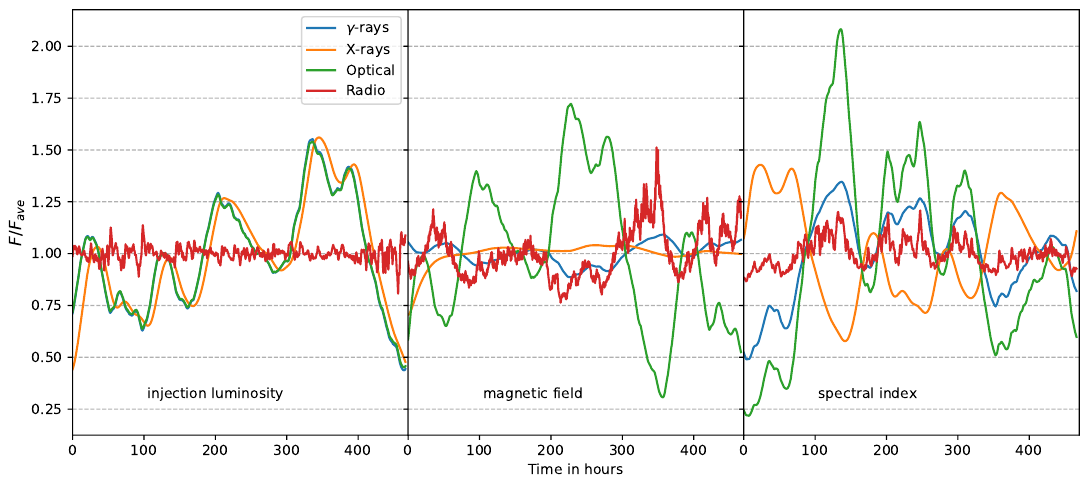
Figure 3. Light curves recovered for variations of injection luminosity ( left ), magnetic field ( middle ) and spectral index ( right ) generated from the time-series shown in Figure 2. Optical and γ -ray light curves for variation of injection luminosity are indistinguishable on hour time-scales.